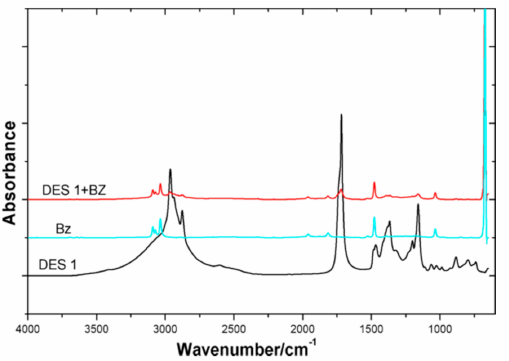
Figure 12. FT-IR spectra of ( a ) DES1 and benzene ( b ) benzene, ( c ) DES1 (DES1 = 0.1 (molar concen-